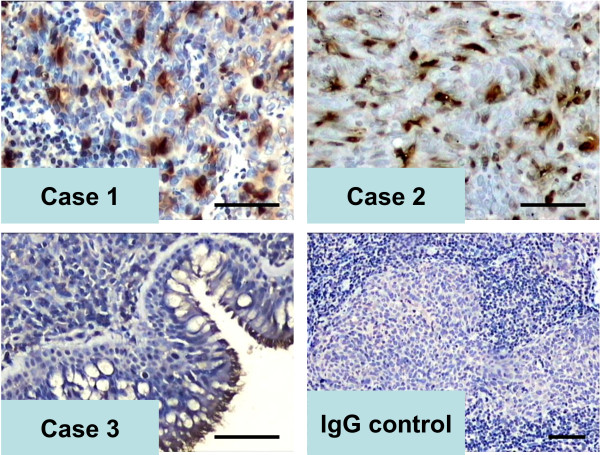
Representative photographs of high UBE2C expression in NPC samples and low UBE2C expression in non-cancerous nasopharyngeal epithelial hyperplasia (NEH). The immunohistochemical PV9000 method was used to detect UBE2C protein expression in clinical samples. Non-immune IgG was used as a negative control. The expression and location of UBE2C in cells was revealed by staining with DAB and counterstaining with hematoxylin. IRS >6.0 in NPC (cases 1 & 2) and IRS <6.0 in NEH (case 3). Original magnification for cases 1–3, ×200, for the IgG control, ×100. Scale bar = 100 μM.